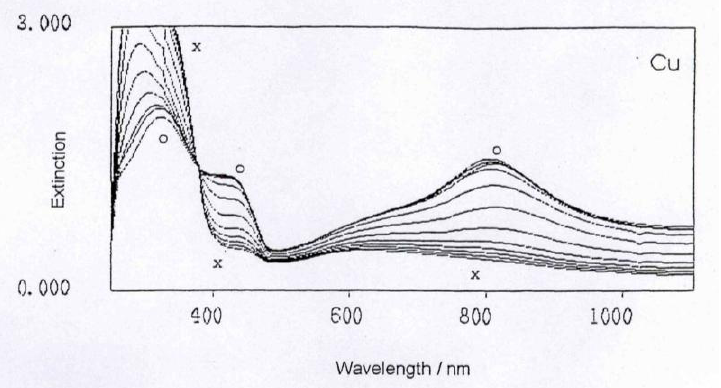
Figure 2. UV-Vis spectrum evolving during the reaction of polyaniline with Cu